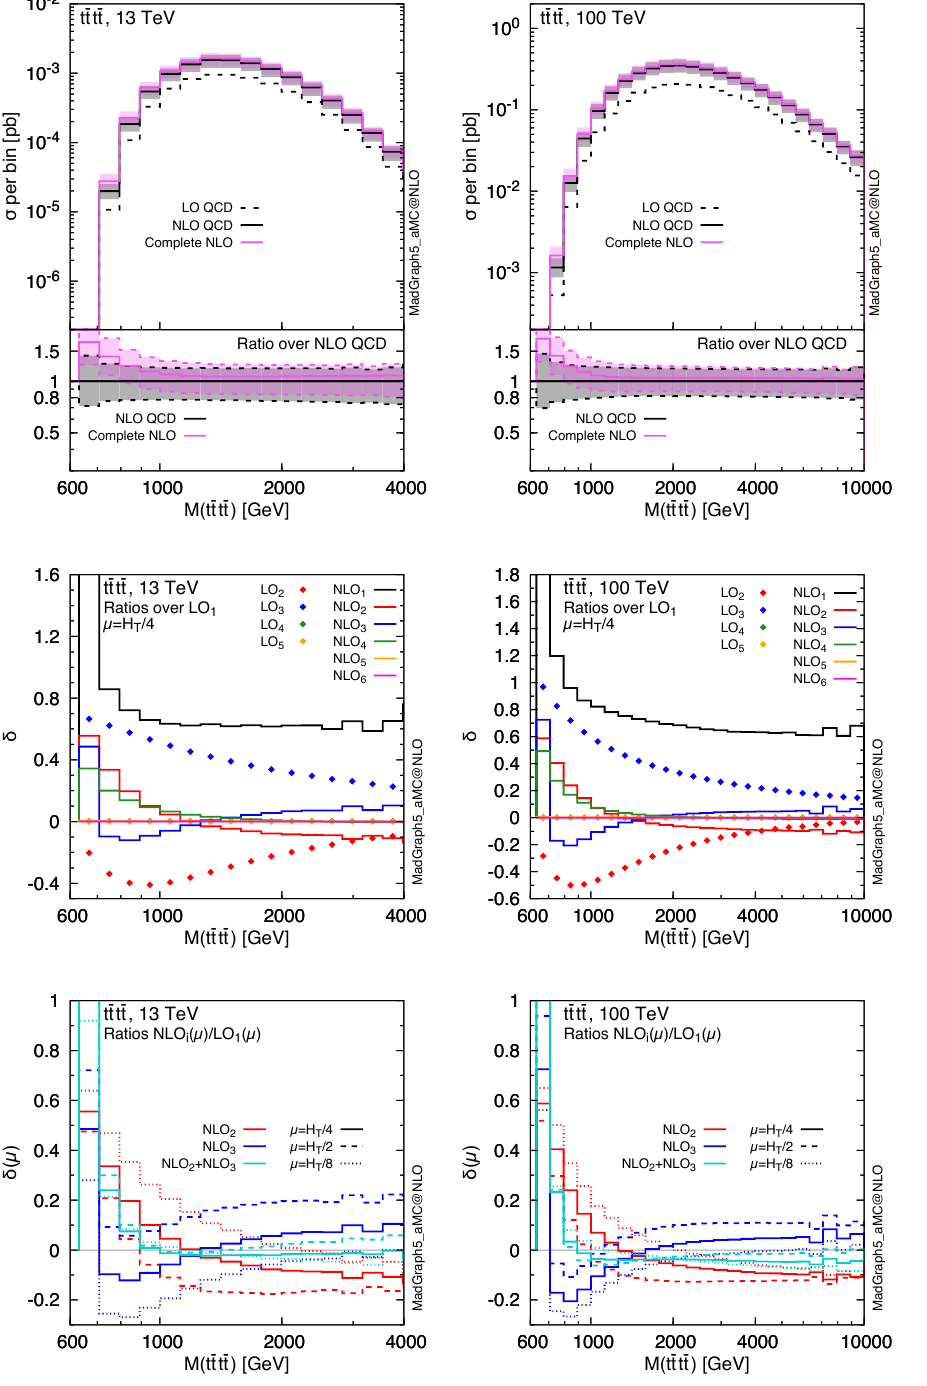
Figure 9 . The m ( t (cid:22) tt (cid:22) t ) distribution in t (cid:22) tt (cid:22) t production. Left: 13 TeV. Right: 100 TeV. Upper plots: scale uncertainty bands (same layout as the plots in (cid:12)gures 5 and 6). Central plots: individual (N)LO contributions normalised to LO 1 (cid:17) LO QCD . Lower plots: same as central plots but only i with NLO 2 , NLO 3 , and their sum, at di(cid:11)erent values of the scale (cid:22) . These lower plots do not show scale uncertainties. Note that NLO 1 (cid:17) NLO QCD and NLO 2 (cid:17) NLO EW .